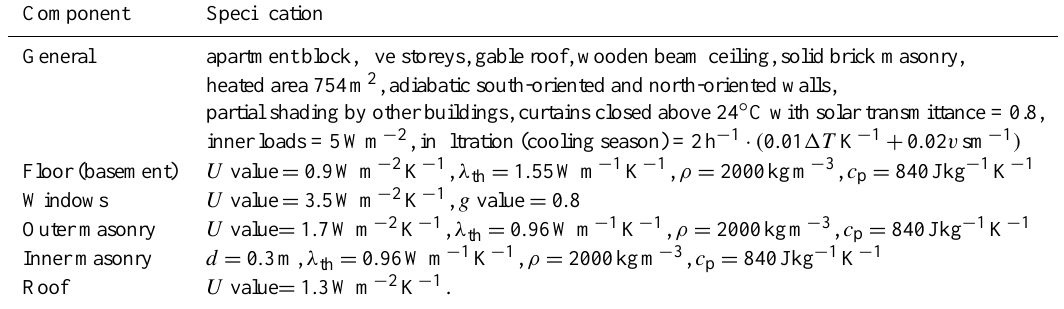
Table 3. Basic assumptions for the implementation of a Berlin residential building from the construction period 1860 to 1918 in the Energy- Plus model (in accordance with IWU, 2011, code DE.N.AB.02.Gen).